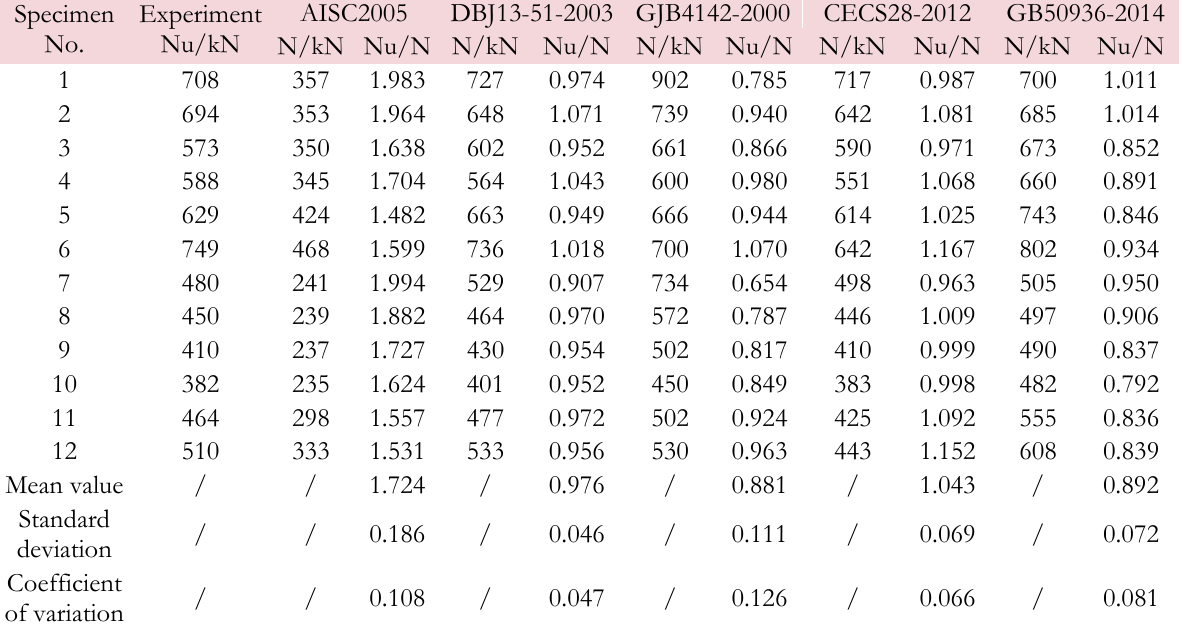
Table 6: Bearing capacity of the